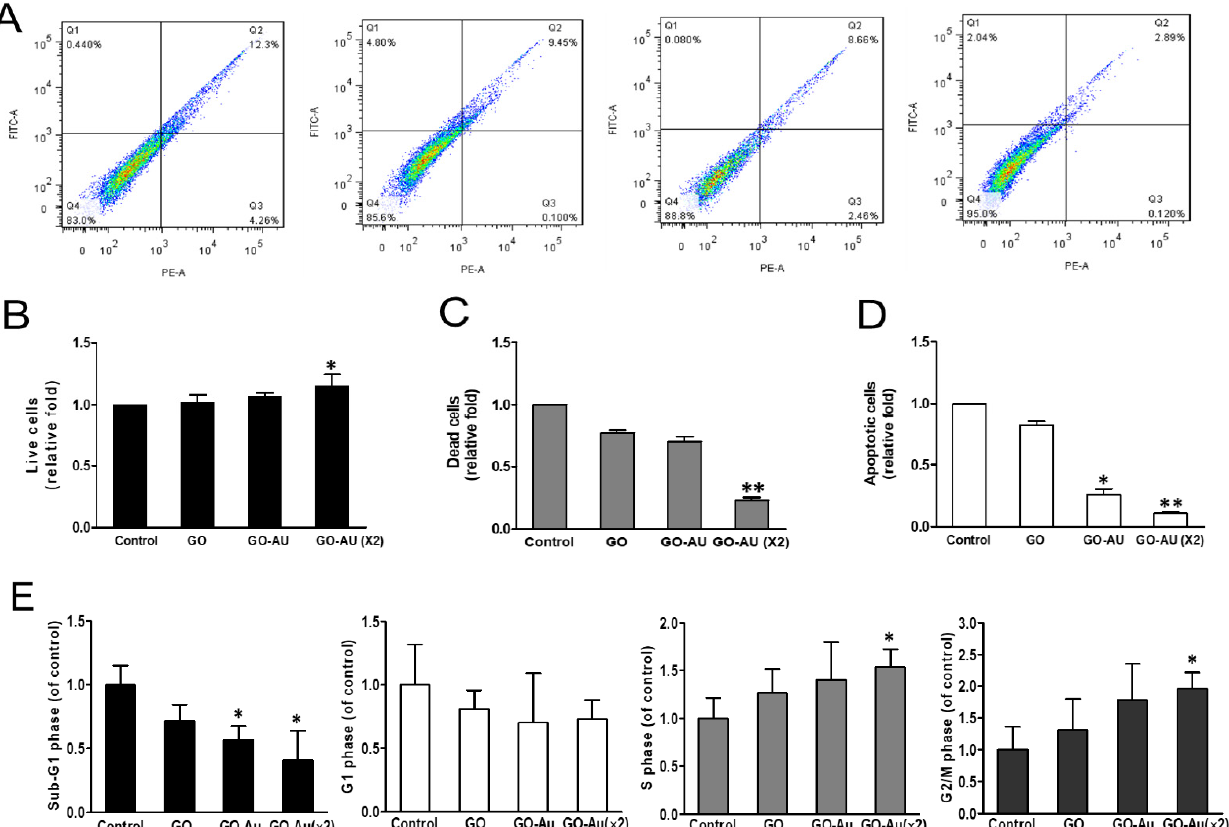
Figure 4. The cell viability assay of MSCs on different materials. ( A ) Annexin V-PI double staining was used by flow cytometry. The results evaluated that the number of ( B ) live cells, ( C ) dead cells, ( D ) apoptotic cells. * p < 0.05 and ** p < 0.01. Cells were cultured on various nanomaterials of GO, GO-Au, and GO-Au (×2) for 24 h, and then cells were harvested and subjected to analyze cell cycle distribution using a flow cytometry analysis. ( E ) The cell cycle distribution was further analyzed and shown in bar graphs. The quantification in respective cell cycle phases of Sub-G1, G1, S, and G2/M. All values were expressed as means ± SD of three independent experiments. * p <